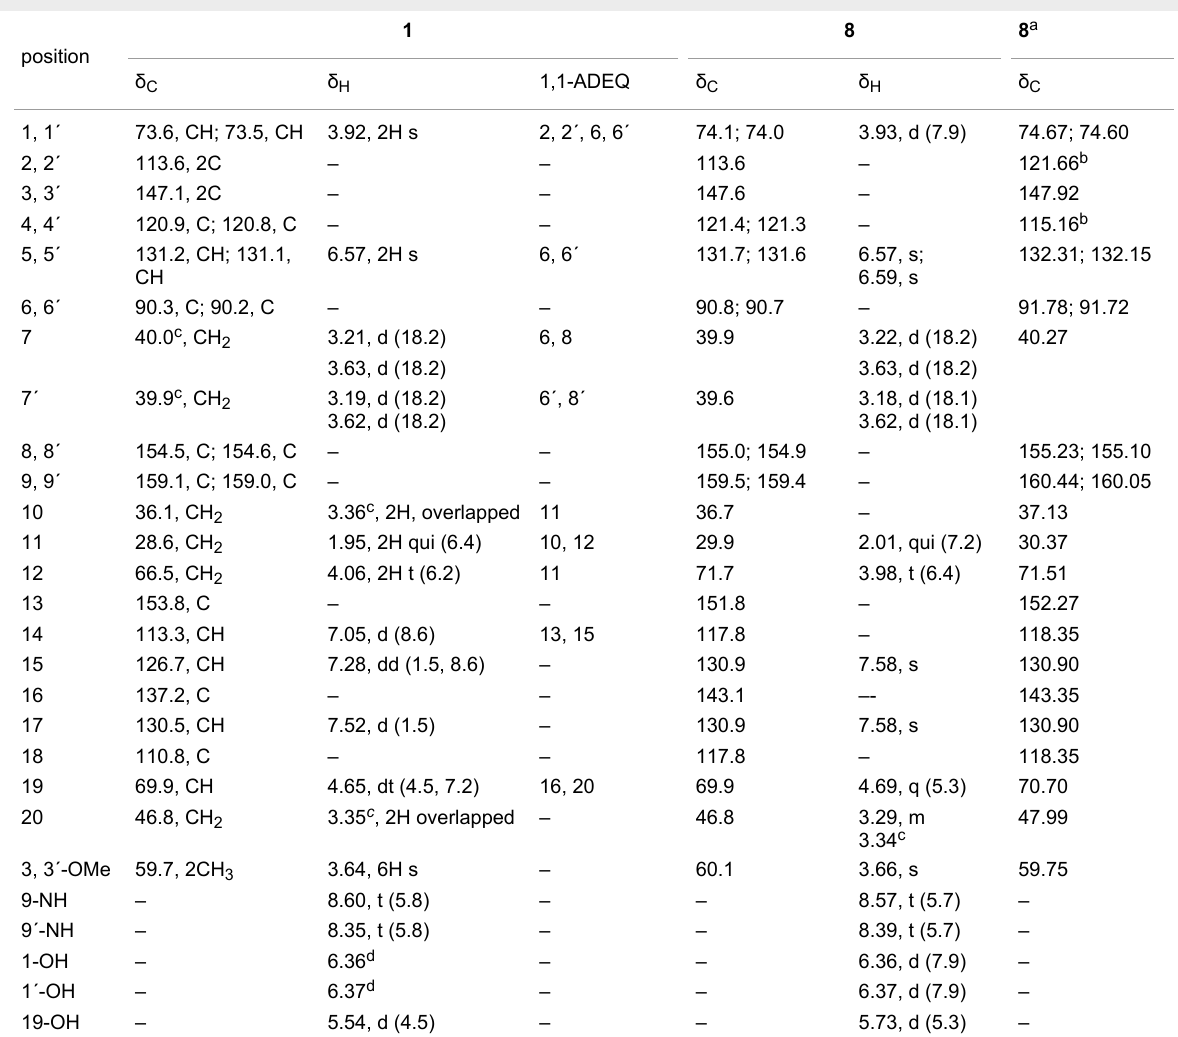
Table 1: NMR data (600 MHz, DMSO- d 6 ) of 14-debromo-11-deoxyfistularin-3 ( 1 ) and 11-deoxyfistularin-3 ( 8 ).